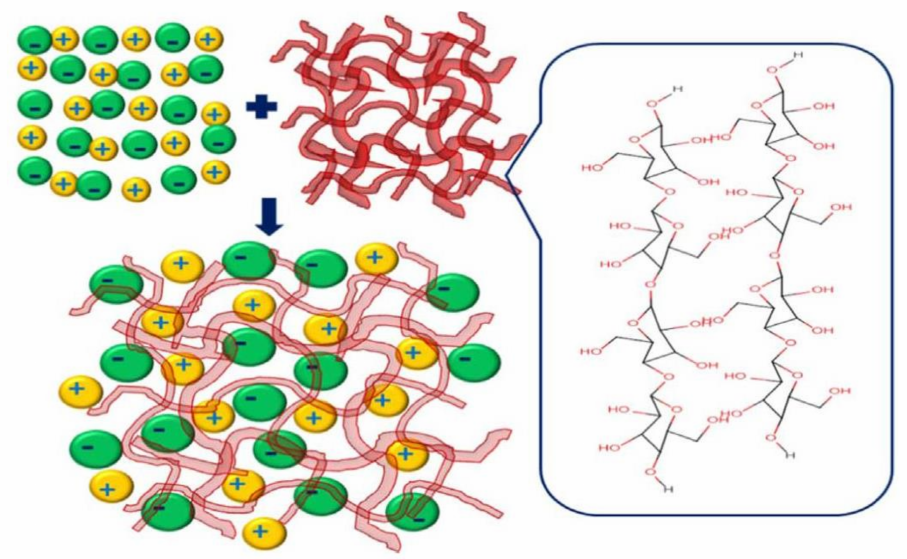
Figure 15. Schematic diagram showing ion dissociation in biopolymer salt matrix. Reproduced with permission from Renew. Sustain. Energy Rev., 65, Singh et al., Perspectives for solid biopolymer electrolytes in dye sensitized solar cell and battery application, 1098–1117, 2016